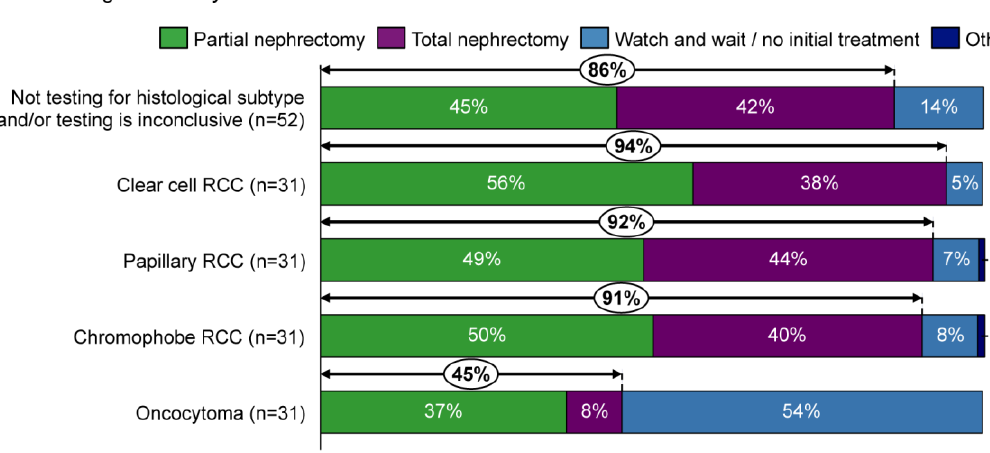
urologists and 50 were